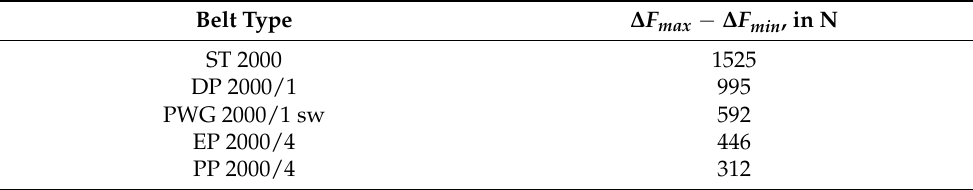
Table 2. Load non-uniformity indicators in the transition section.